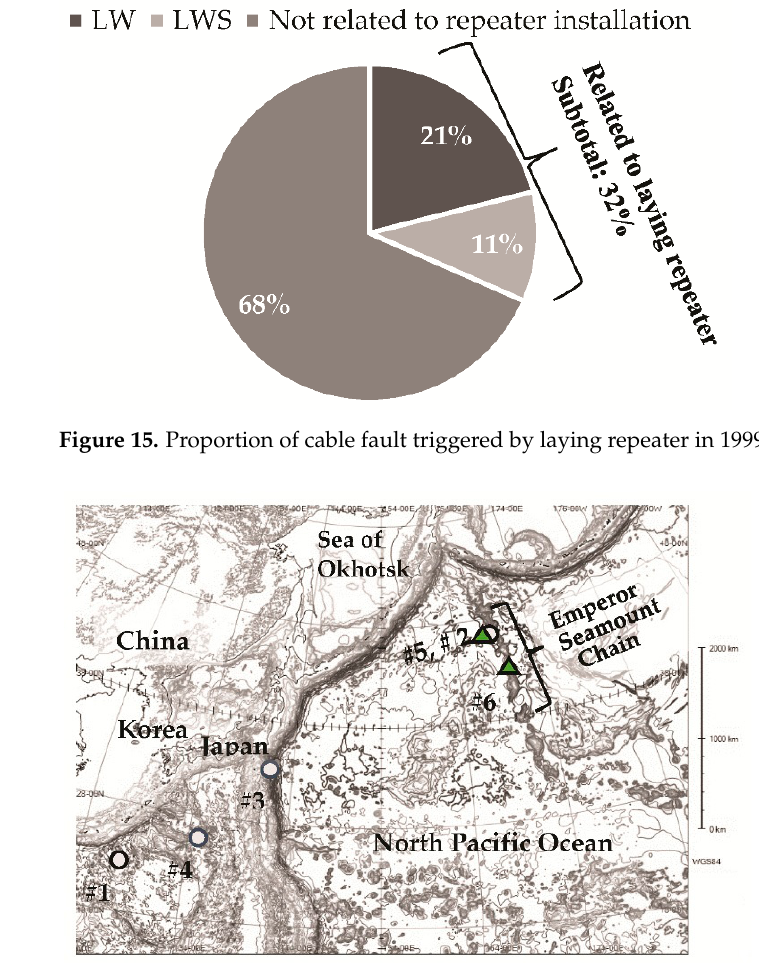
Figure 18. Individual situation of cable faults related to laying repeater in LWS. (3) Details of the fault. Figure 17. Individual situation of cable faults related to laying repeaters in LW cable.